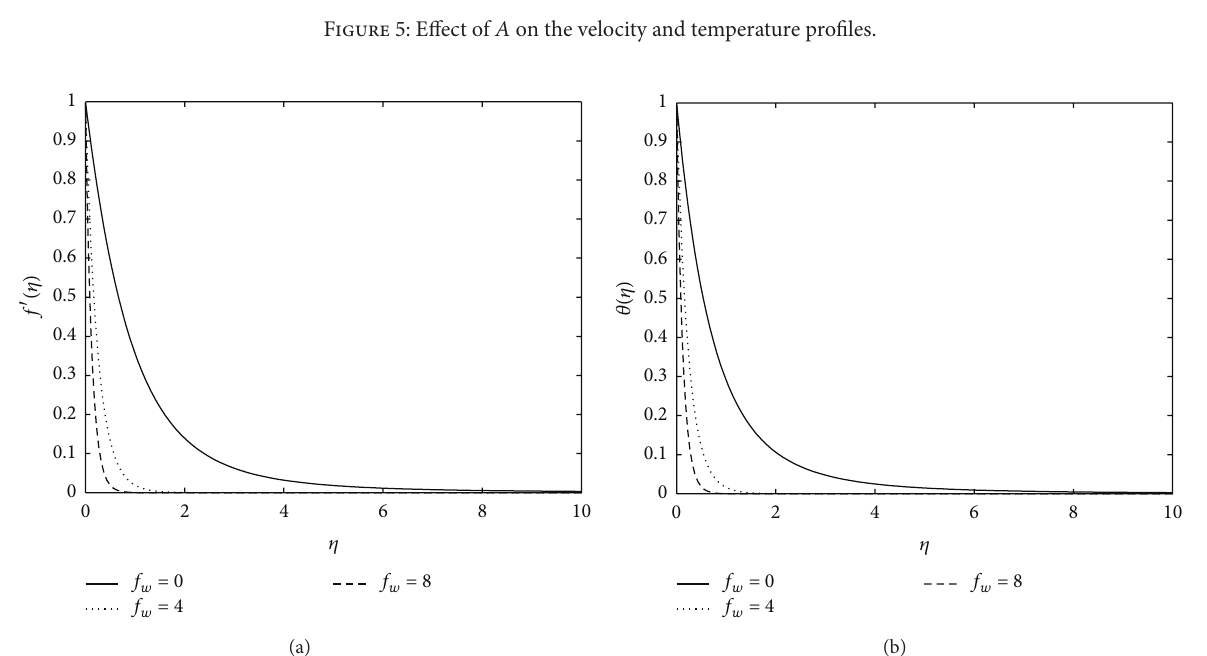
Figure 6: Effect of 𝑓 𝑤 on the velocity and temperature